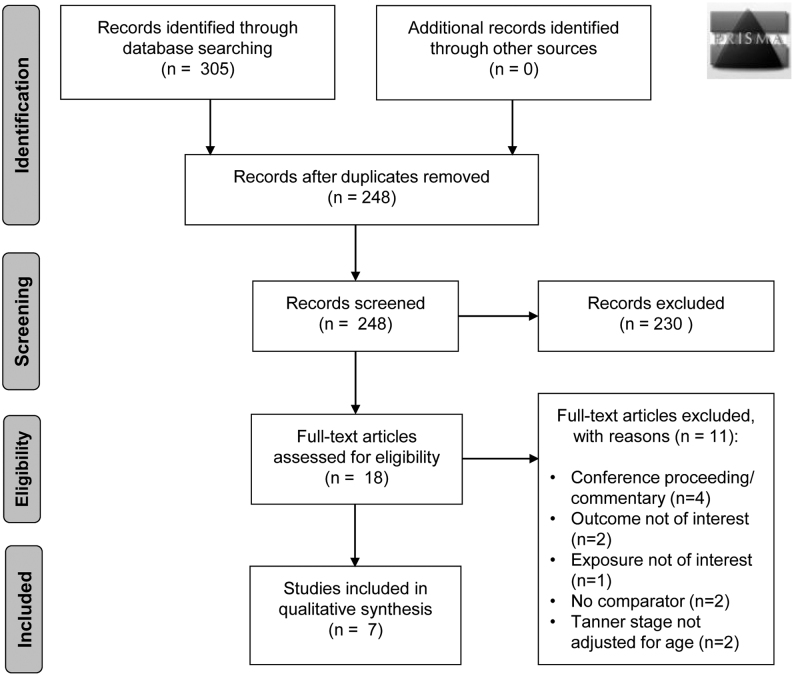
PRISMA flowchart.